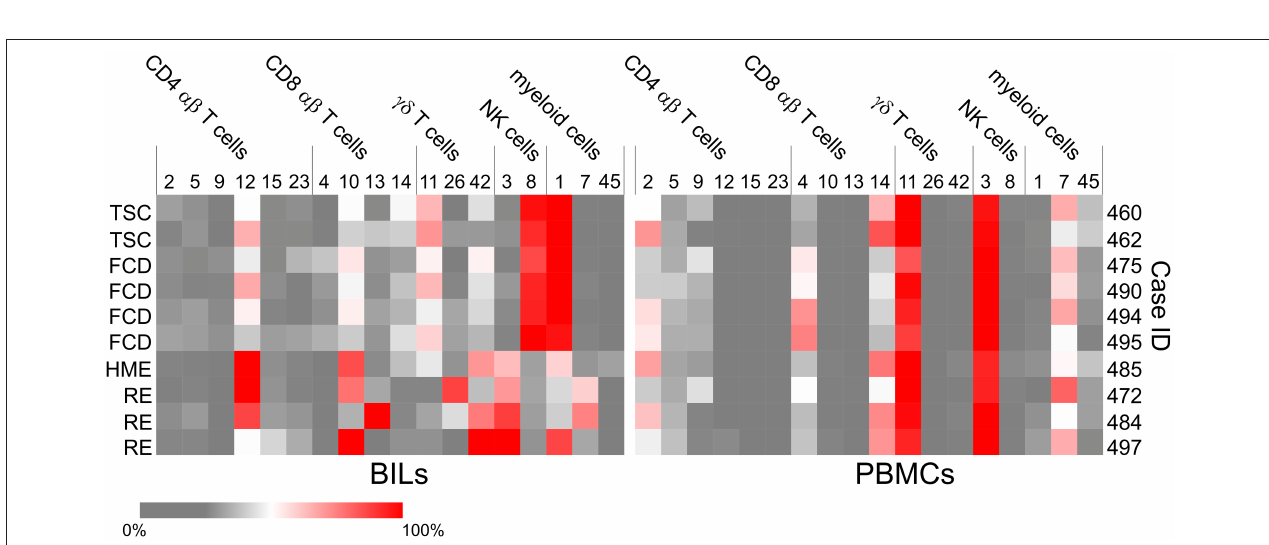
FIGURE 4 | Immune cell profiles of BILs. Donut plots show the relative number of lymphoid cells, myeloid cells and B cells in the BIL fractions isolated from resected brain tissue. Lymphoid cells are divided into CD4, CD8, and γδ T cells and NK cells. Each chart corresponds to one of the surgery cases, and are arranged according to the clinical diagnosis (TSC: 460, 462; FCD: 475, 490, 494, 495; HME: 485; RE: 472, 484, 497). The data are presented as percentages of the number of CD45 + cells in each BIL fraction.